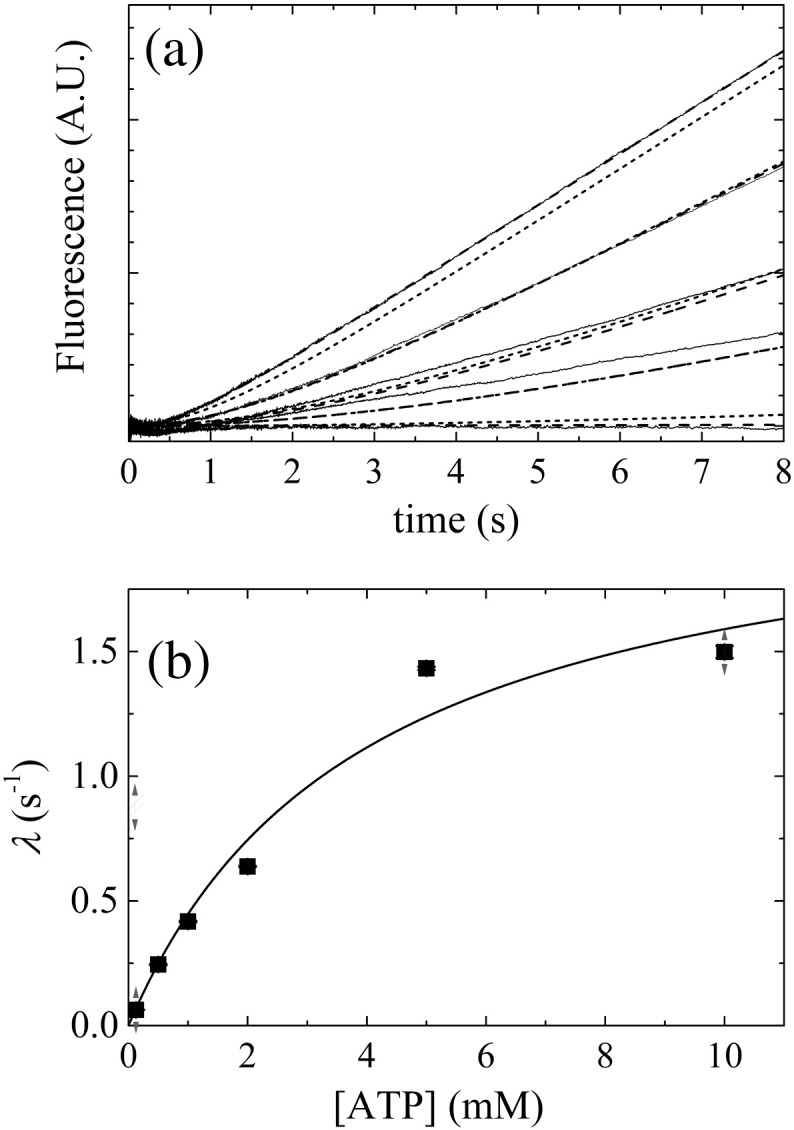
Transient and steady-state Pi release during Dbp5 ATPase cycling. (a) Time courses of fluorescence change after mixing 0.5 μM Dbp5 with 5 μM PiBiP containing (lower to upper curves) 0, 0.5, 1, 2, or 5 mM ATP. Fits to Eq. (14) are shown as broken lines through the data. Simulated data (using rate and equilibrium constants obtained from KinTek Explorer global fitting; Table 2) are shown as dotted lines through the data. (b) [ATP] dependence of the observed Pi release lag phase rate constant (λ). Continuous line through the data points represents best fit to a rectangular hyperbola [Eq. (15)].